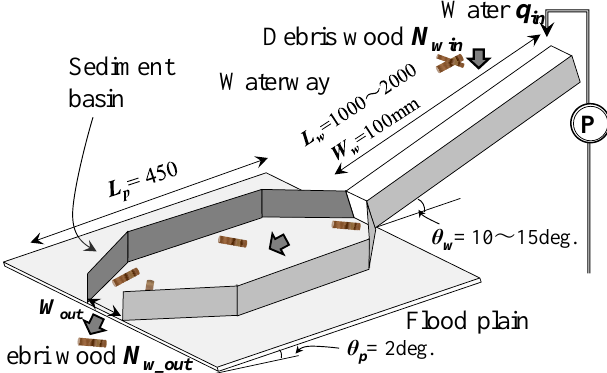
Figure 13. Outline of the experiment.